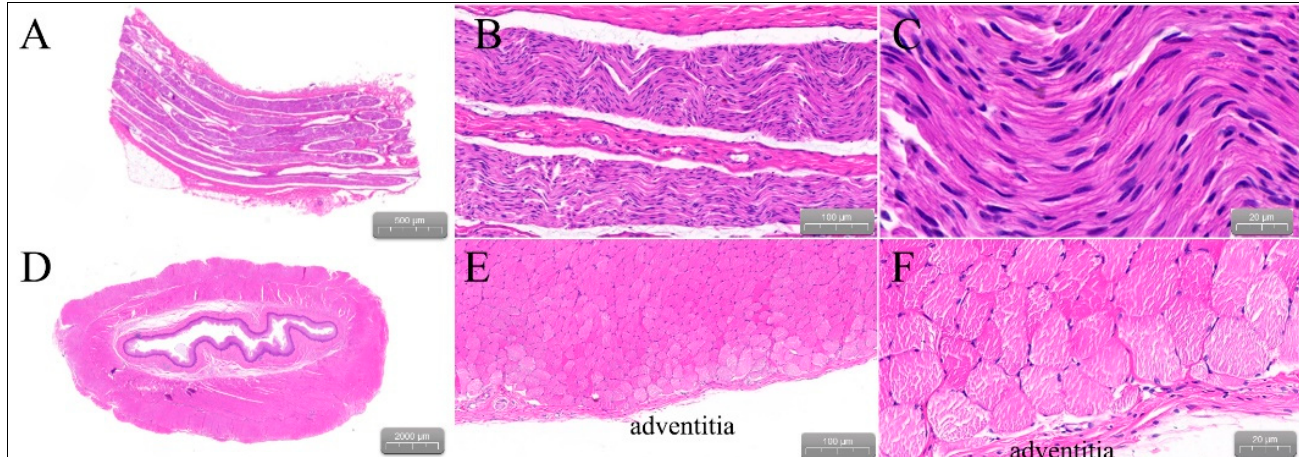
Figure 7. Hematoxylin and Eosin (E&A) staining. ( A – C ) Represent the phrenic nerve. ( D – F ) Repre- sent the esophagus. Note that the cell boundaries are clear and neatly arranged without any damage.